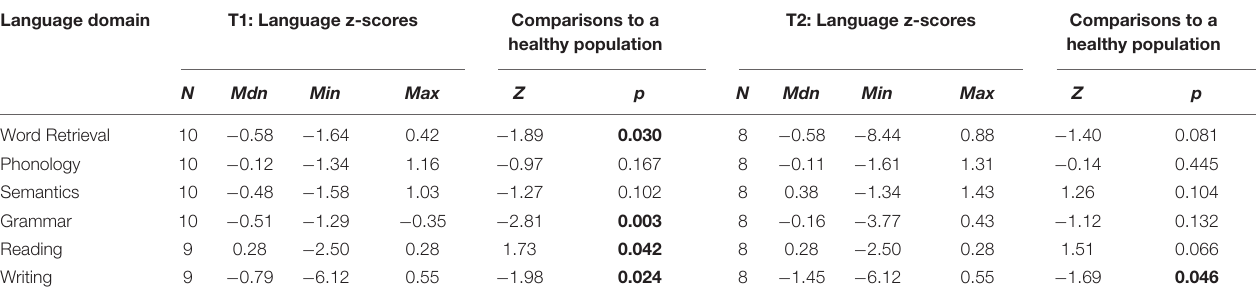
TABLE 5 | Language domain z-scores of meningioma patients at T1 and T2, including comparisons to normative data from a healthy population. Language